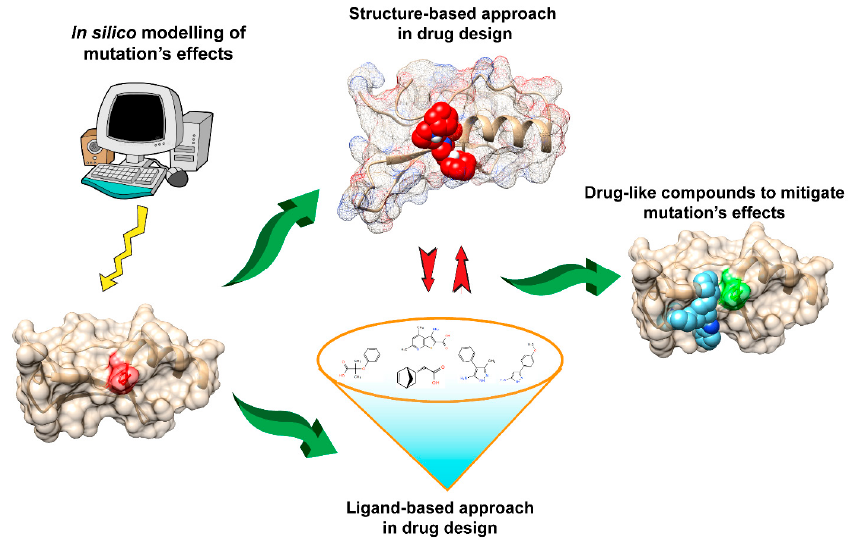
Figure 4. Schematic presentation of the drug discovery process to mitigate the effects of disease- causing mutations.